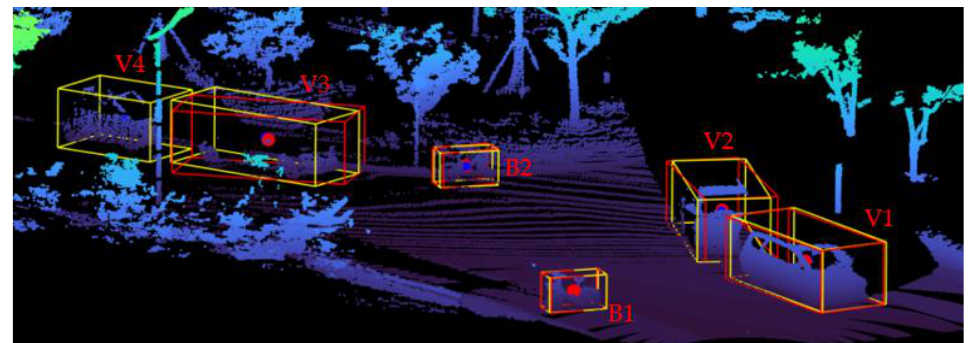
Figure 27. The ANFIS results in the outdoor test scene: ( a – e ) the ANFIS results of recognized tar- gets with the same mask color in Figure 26.